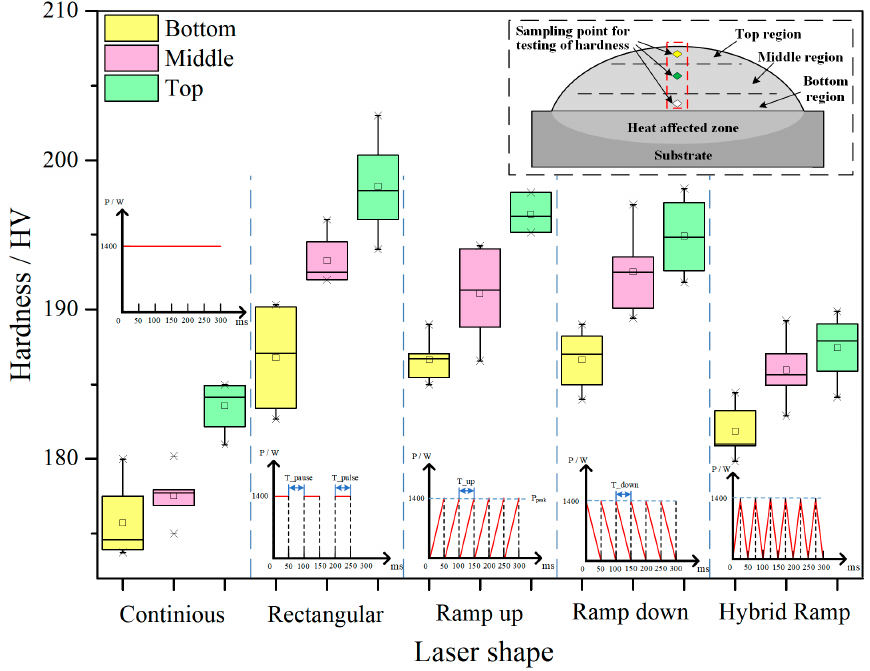
Figure 8. Microhardness at different regions of AISL316L deposition produced by different laser shape. (Reprinted from ref. [29], copyright (2020), with permission from MDPI.).